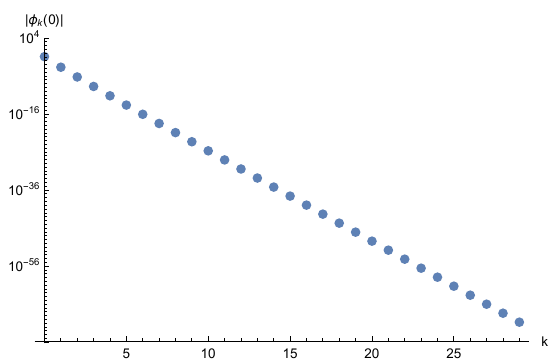
Figure 31 . Fourier spectrum at the origin of the periodic solution given by ! b = 2, (cid:26) b = 0 : 01 and (cid:26) 0 = 0 : 1.